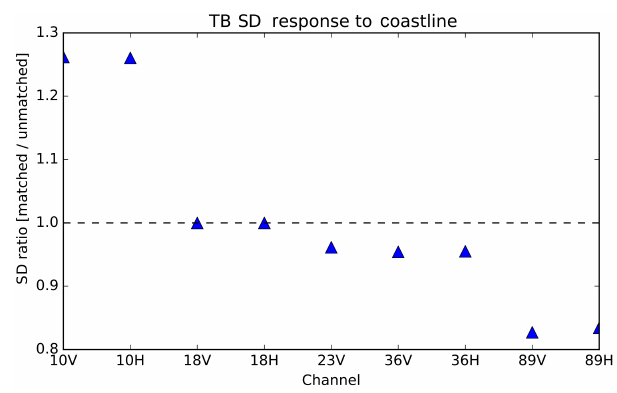
Figure 9. For the coastal data depicted in Fig. 8, the effect of res- olution matching on the standard deviations of the brightness tem- peratures from each channel is